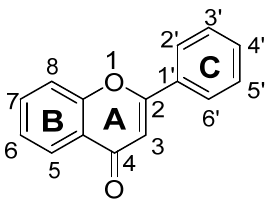
Figure 12. SAR of Flavones.